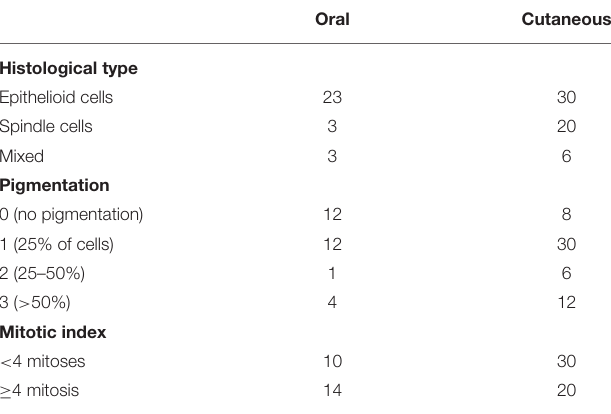
TABLE 3 | Clinicopathological parameters of the oral and cutaneous melanomas. Oral Cutaneous